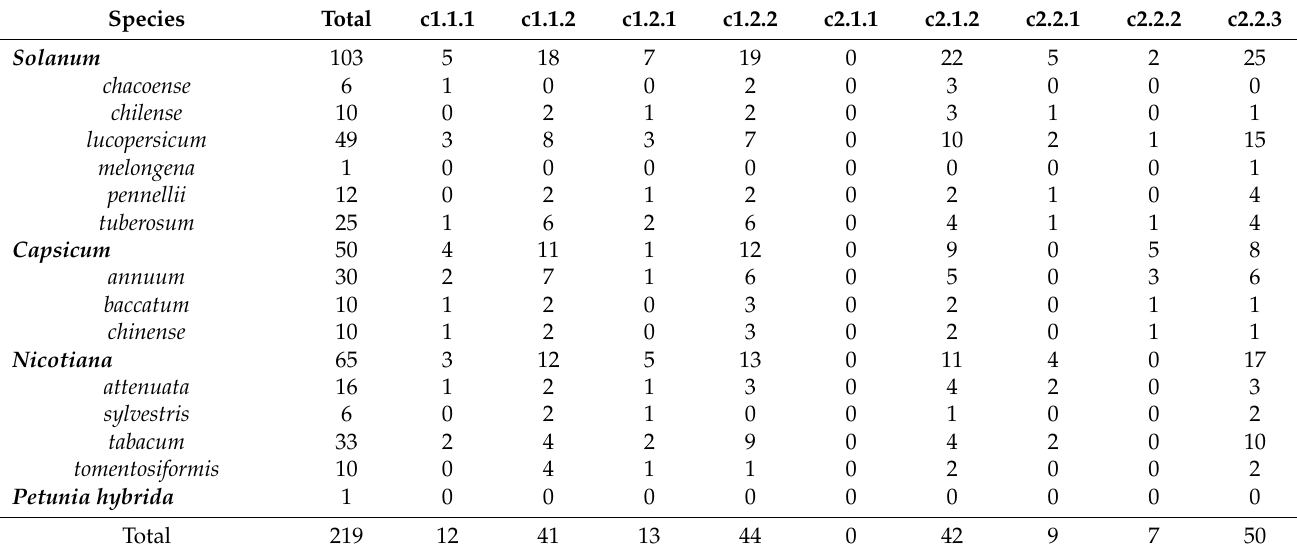
Table 4. The occurrences of the MLO sequences from species of the Solanaceae family in the nine phylogenetic clades.